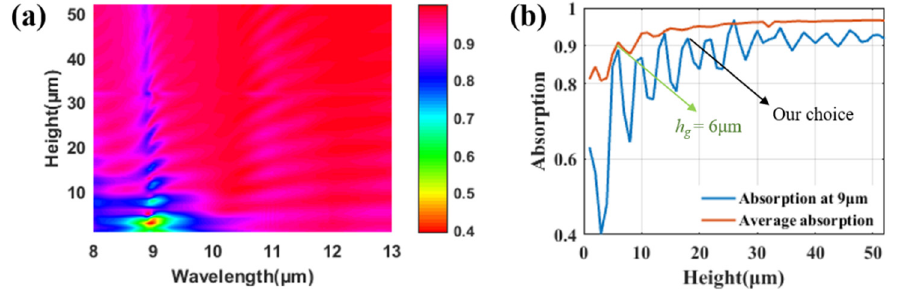
Figure 8. ( a ) Emissivity of the proposed structure varying with the height of the grating ( h g ) in the atmospheric transparent window. ( b ) Blue line: emissivity at 9 μ m varying with the height of the grating. Red line: average absorption in the atmospheric transparent window.